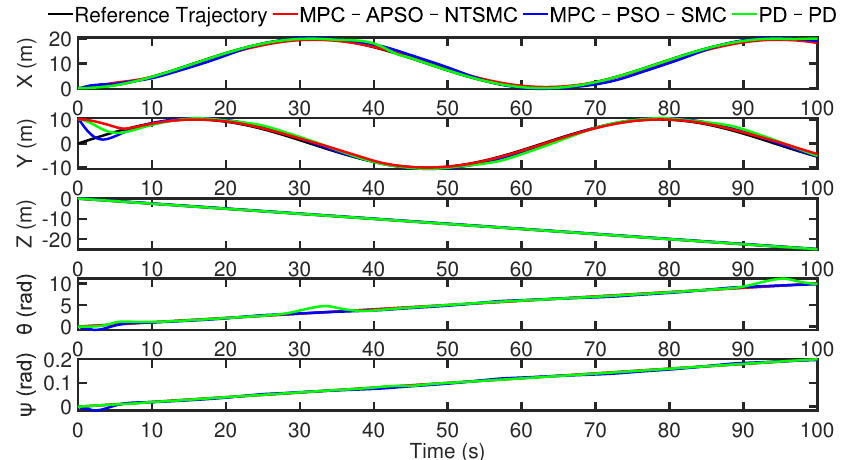
Figure 10. Position tracking performance for the tracking task without disturbance for Case